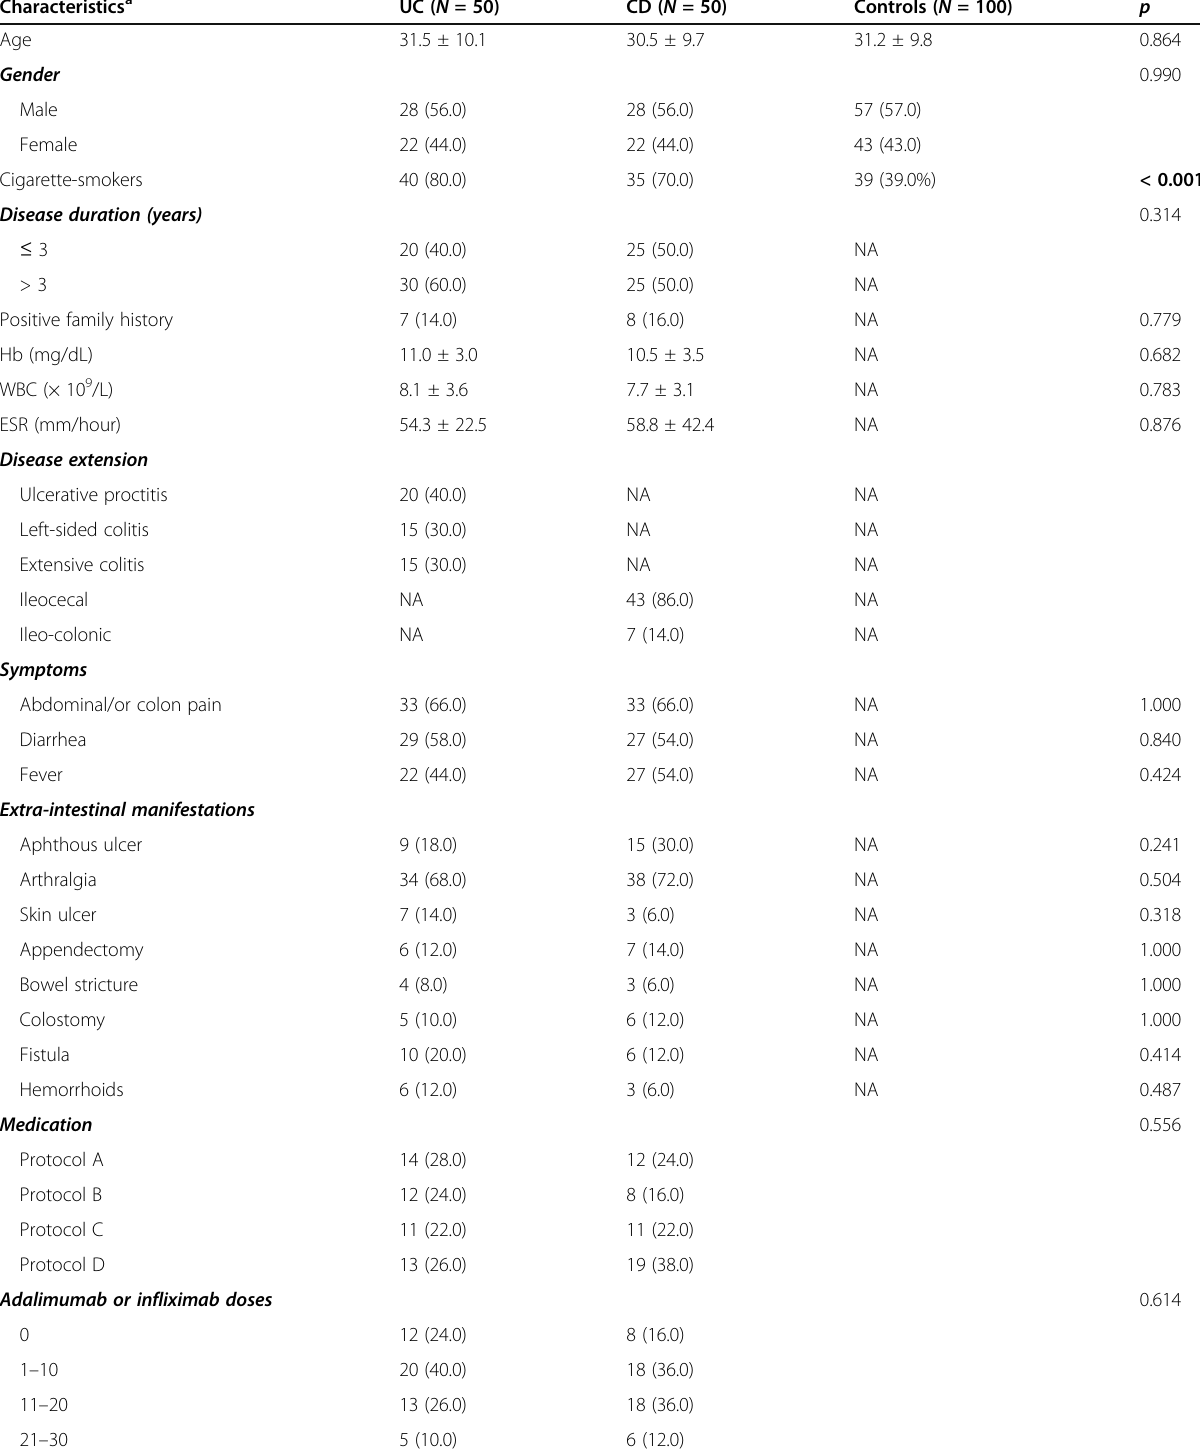
Table 1 Baseline characteristics of inflammatory bowel disease (ulcerative colitis and Crohn ’ s disease) patients and controls Characteristics a